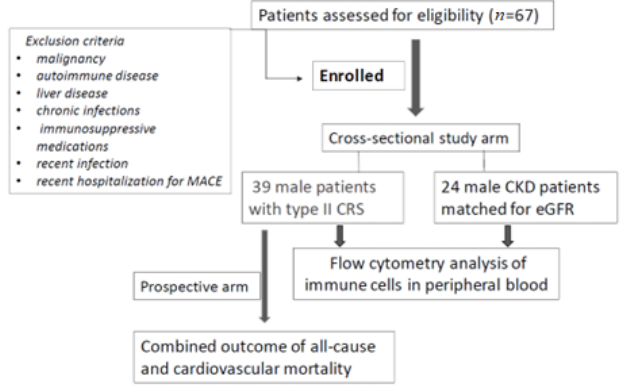
Figure 1. Flowchart of the study.